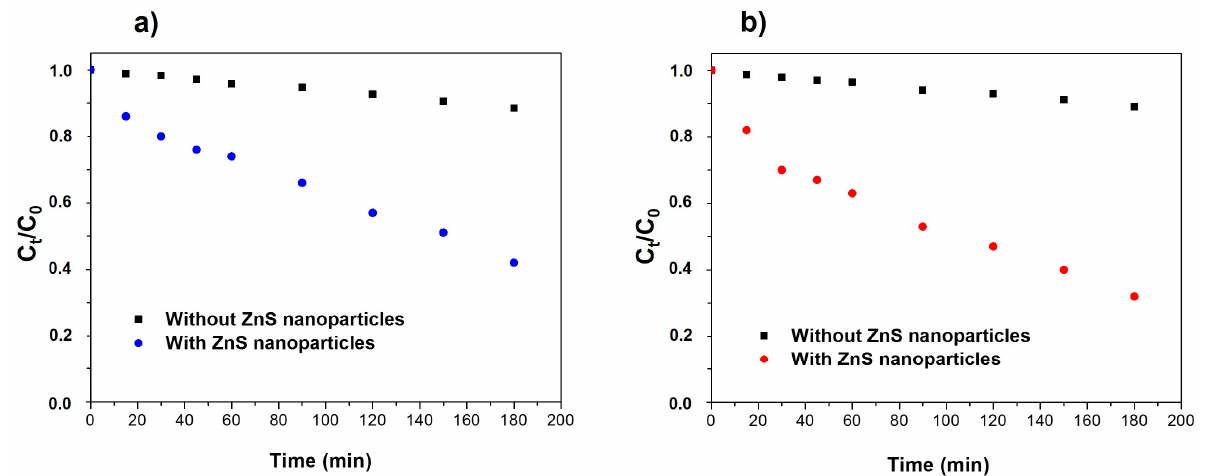
Figure 6. Photocatalytic degradation of ( a ) methylene blue and ( b ) rodhamine_B with and without a ZnS photocatalyst irradiated with UV light.